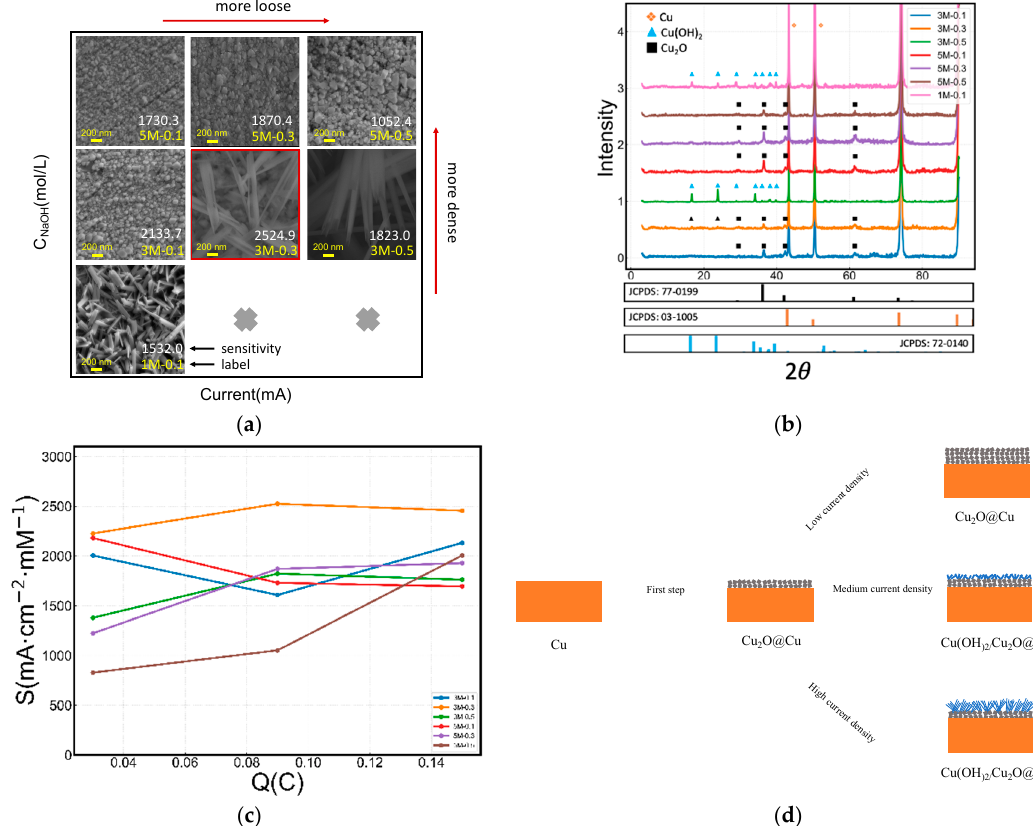
Figure 4. ( a ) SEM images. ( b ) XRD patterns of sensors prepared in different NaOH concentrations and current intensities. ( c ) The relationship between sensitivity and charge consumption during preparation for the Cu 2 O electrodes fabricated under different conditions. ( d ) Crystal growth mechanism of electro-oxidation of Cu as an anode under alkaline conditions.